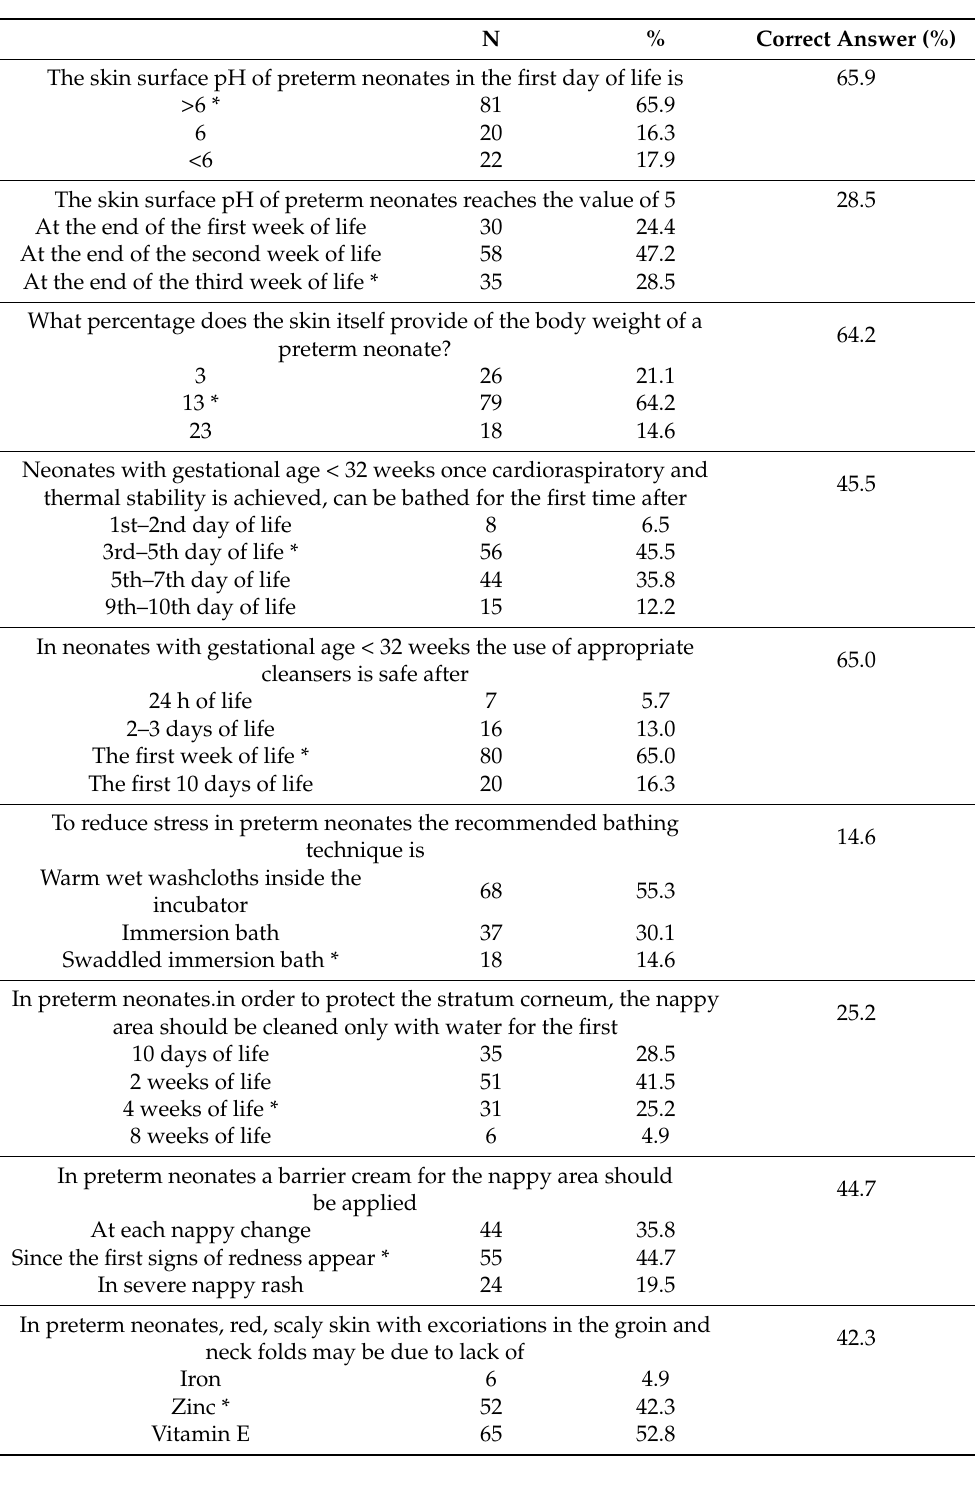
Table 4. Questions and healthcare professionals’ performance regarding evidence-based clinical practices for preterm neonatal skin